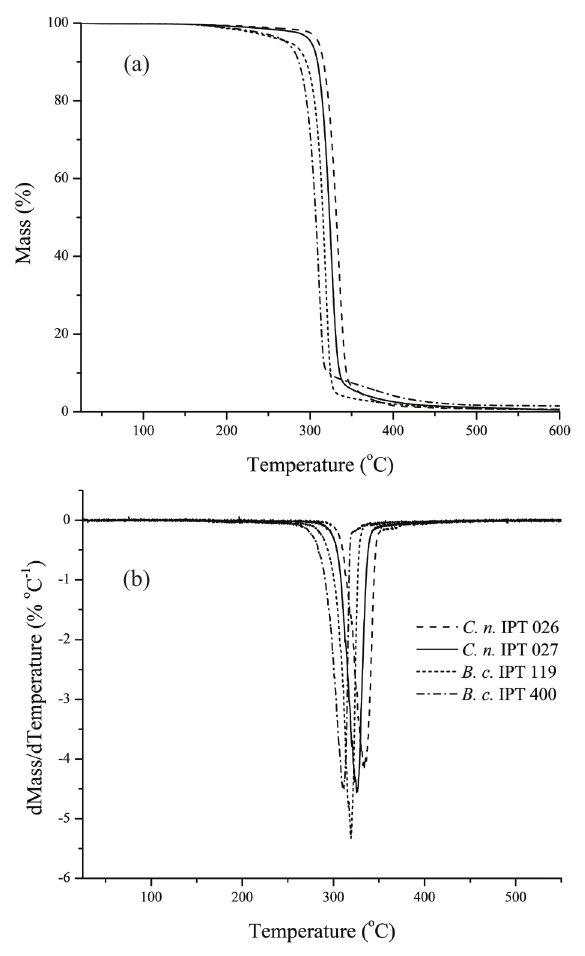
Fig. 4 – TGAs (a) and DTGs (b) of crude palm oil and PHAs produced by C. necator and B. cepacia strains in submerged cultivation